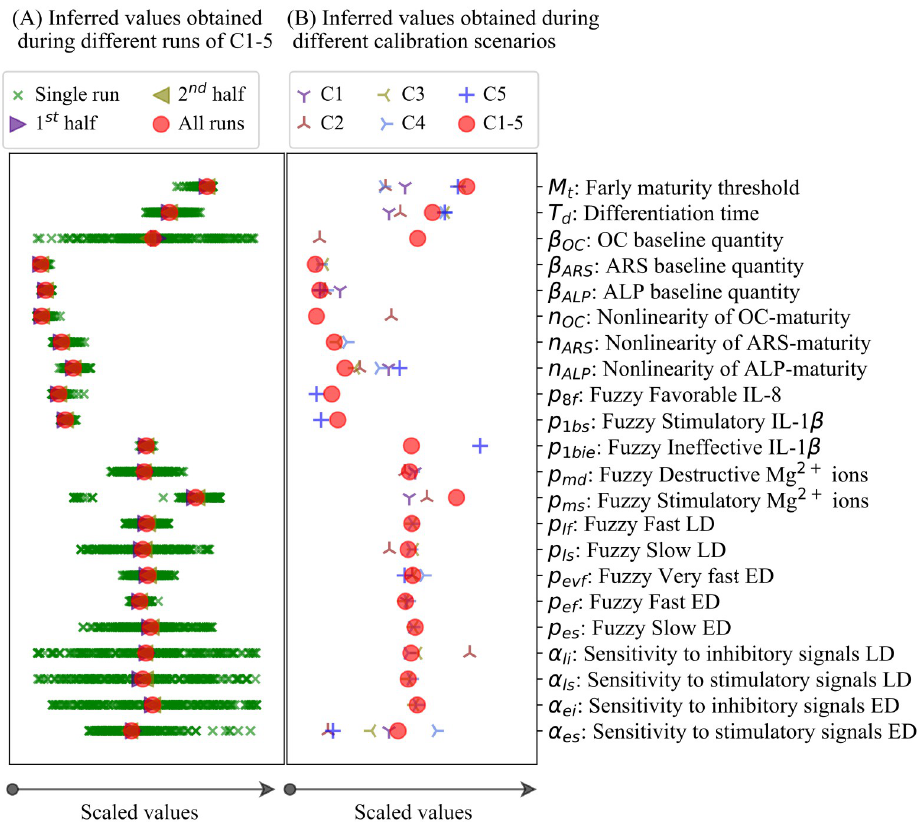
Fig 8. (A) Dispersity of the inferred values obtained during different runs of C1-5. In total, the calibration process is repeated 200 times in order to reach the stable inferred values, which is achieved by overlapping the mean values of all runs with the mean values of the 1 st and 2 nd halves of all runs. (B) Dispersity of the parameter values obtained during different calibration scenarios of C1, C2, C3, C4, C5, and C1-5. The values were scaled by dividing by the length of the priors. ED and LD stand for early differentiation and late differentiation,